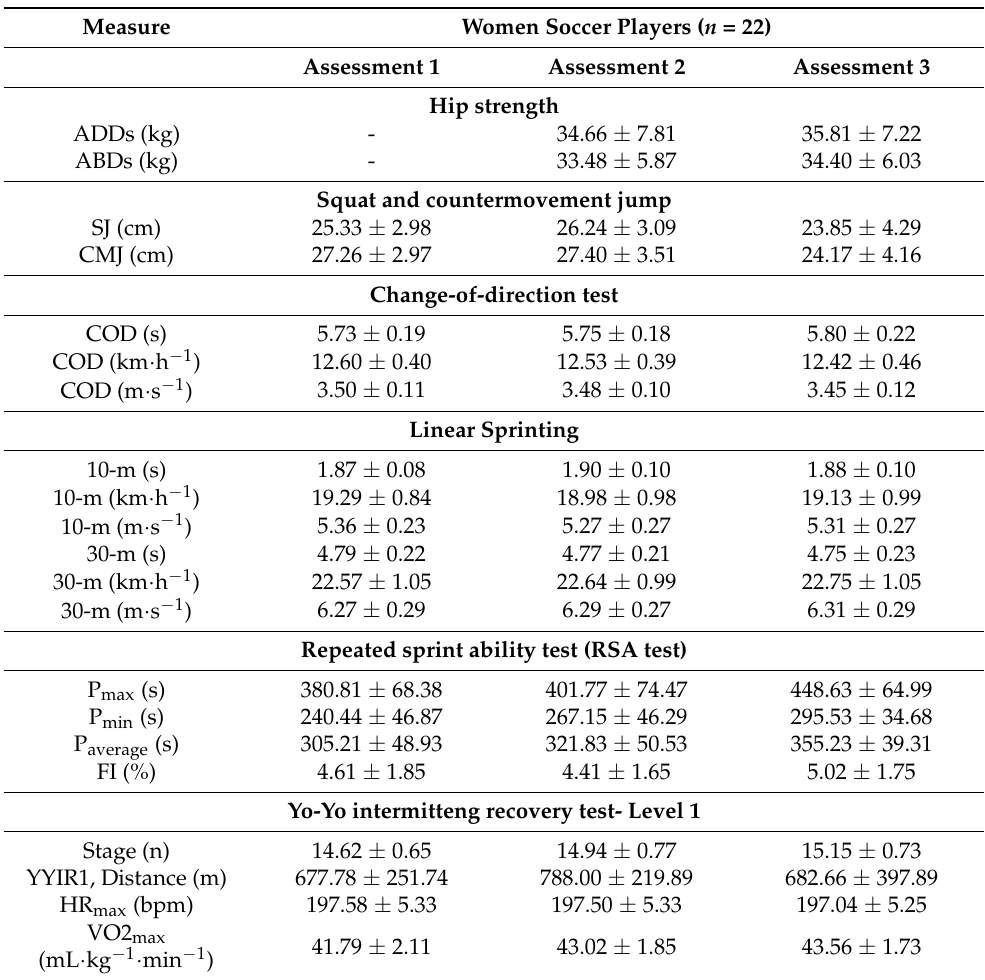
Table 1. Physical fitness assessment (mean ±